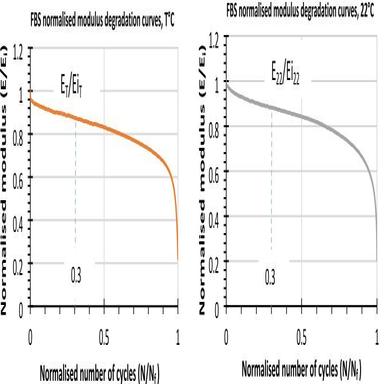
Normalised modulus degradation curves of FBS specimens at T ℃ and 22 ℃.